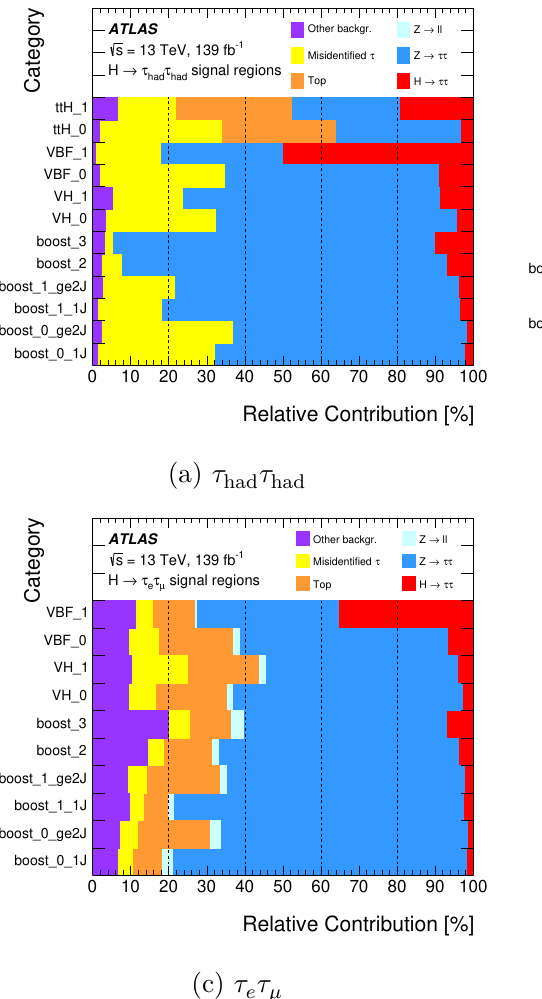
τ , (b) τ τ and (c) τ τ channels, within 100 GeV< m MMC had had lep had e µ